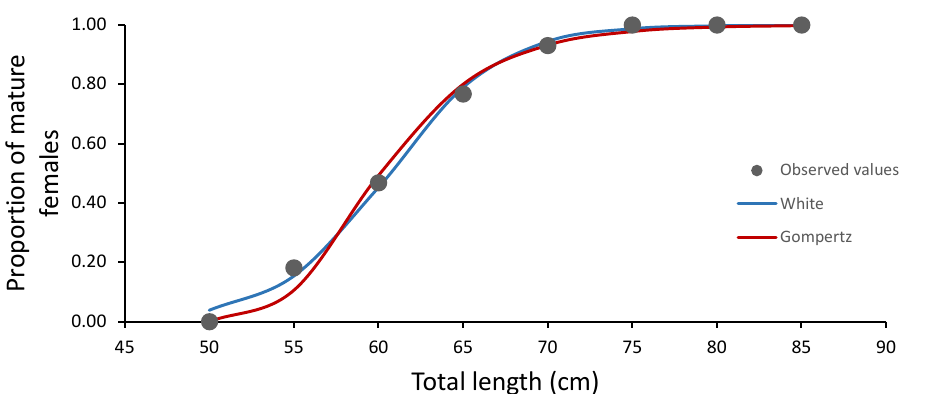
Figure 5. Sigmoid and logistic models (lines) fitted to the length at maturity data (points) for female giant electric rays, Narcine entemedor.